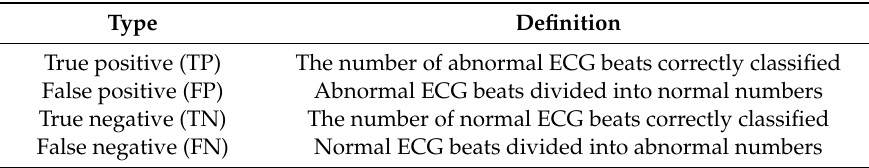
Table 3. Definition of four classification